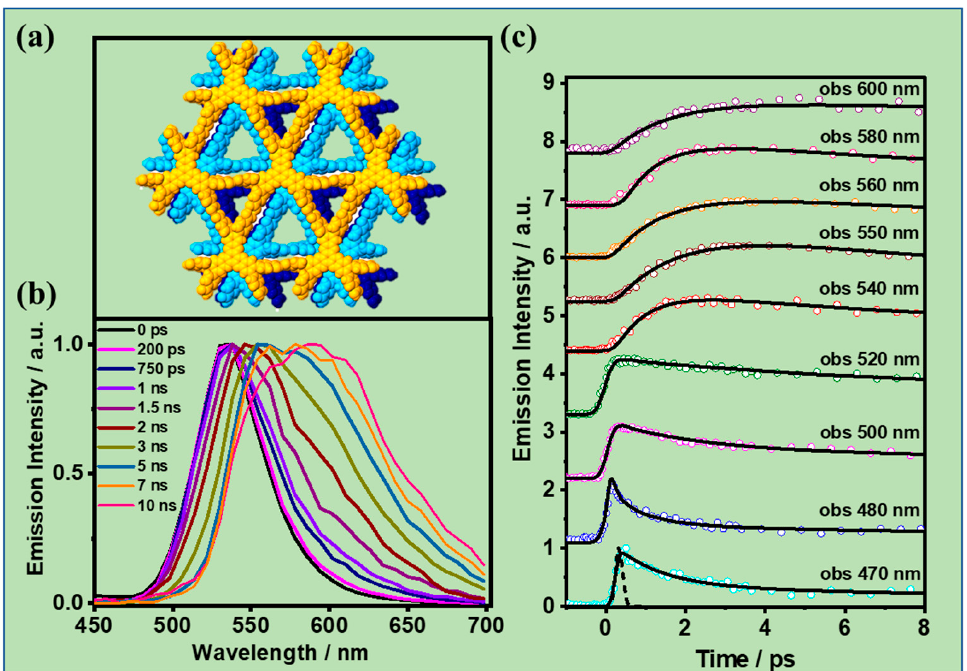
Figure 7. ( a ) Framework of CPHATN-1a. ( b ) Ps-time-resolved emission spectra and ( c ) femtosecond (fs)-emission transients of CPHATN-1a crystals. The observation wavelengths and gating times are indicated in the insets. The dashed line in ( c ) is the instrumental response function (IRF).